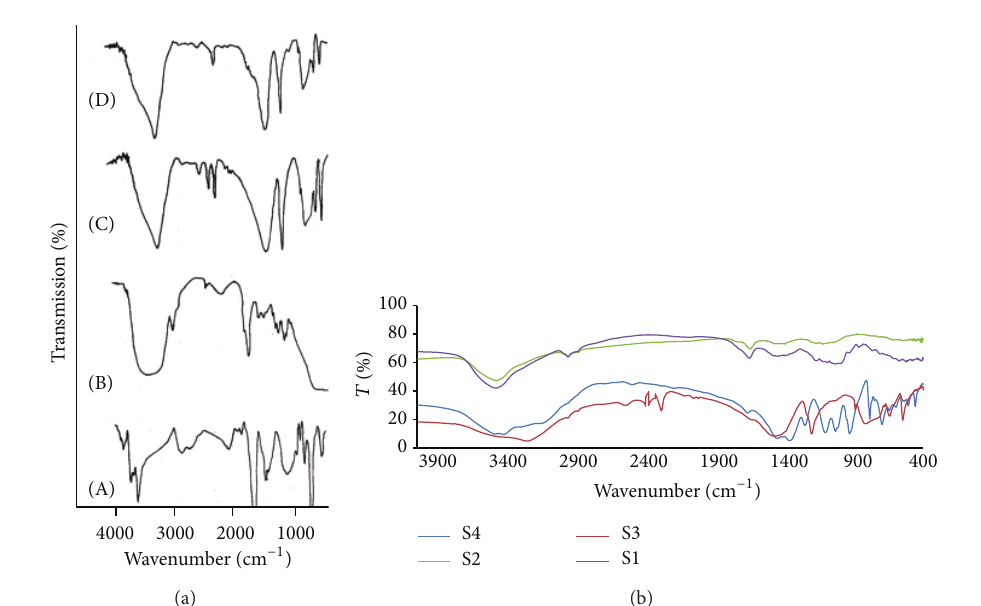
Figure 6: (a) FTIR of (A) potato starch, (B) GA, (C) boric acid, and (D) complex material. (b) FTIR of S1: sample kept in 20% RH, that is, relative humidity (without growth region) S2: sample kept in 70% RH (without growth region) S3: Sample kept in 70% RH (growth region only), S4: Sample kept in 20% RH (growth region